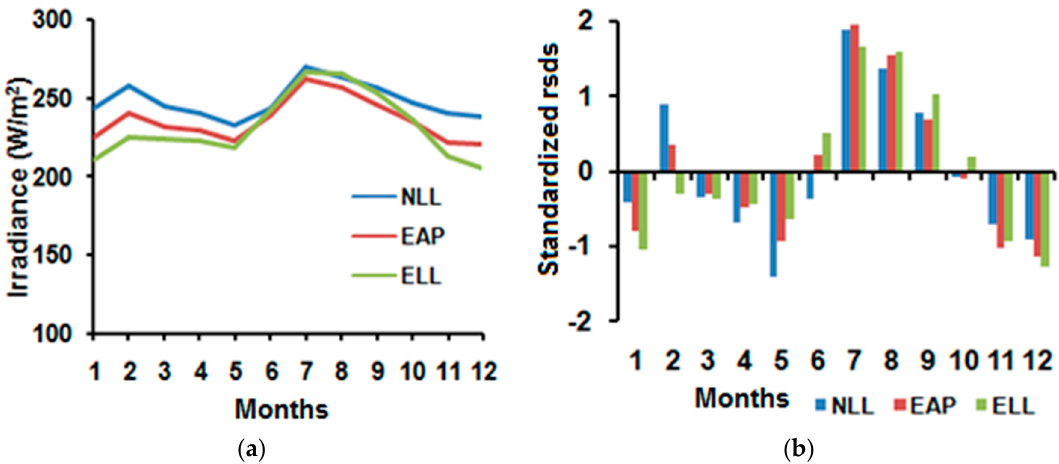
Figure 4. Monthly ( a ) solar irradiance patterns; ( b ) standardized solar irradiance at NLL, EAP, and ELL.